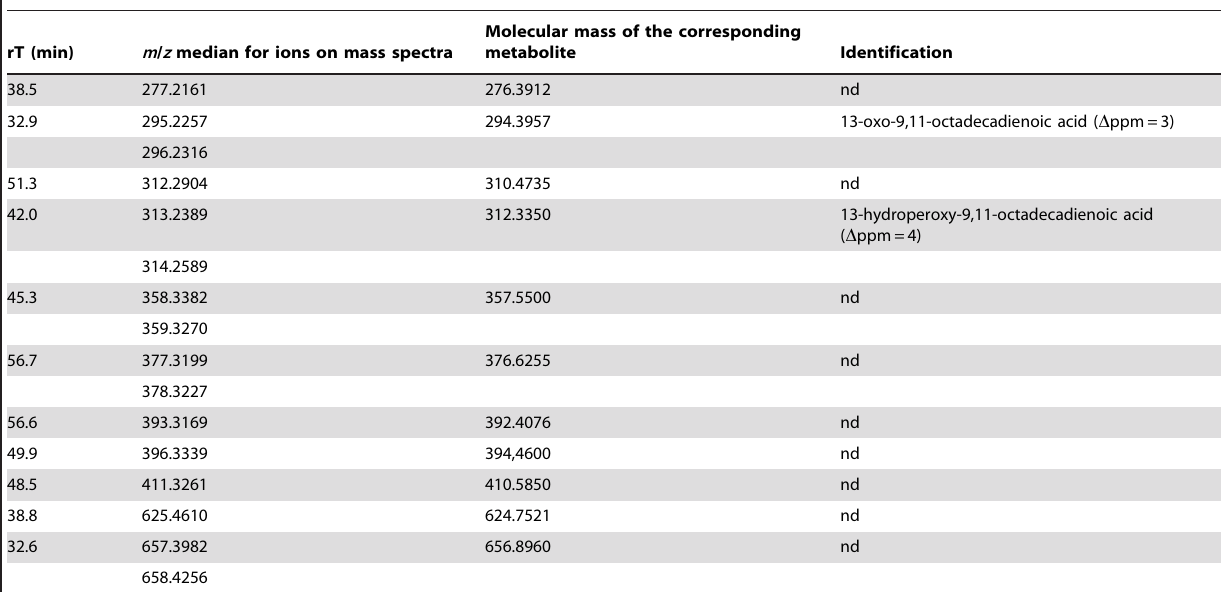
Table 1. Metabolites induced by P. variabile during the competition with the phytopathogen F. oxysporum.